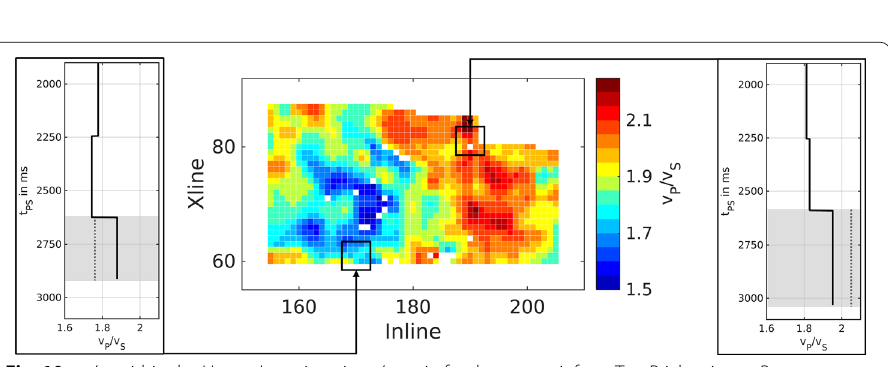
Fig. 10 v p /v s within the Upper Jurassic unit. v p /v s ratio for the reservoir from Top Priabonian to Base Tithonian (grey areas, see Fig. 1 for stratigraphic position). Each pixel corresponds to a single bin (50 m 2 ). The relative distribution of the traveltime-derived ratios are collaborated by the sparsely applied velocity analysis points (left- and rightmost figures). The black dashed line in the panels represents the averaged traveltime-derived v p /v s value of the corresponding supergathers (black squares in the